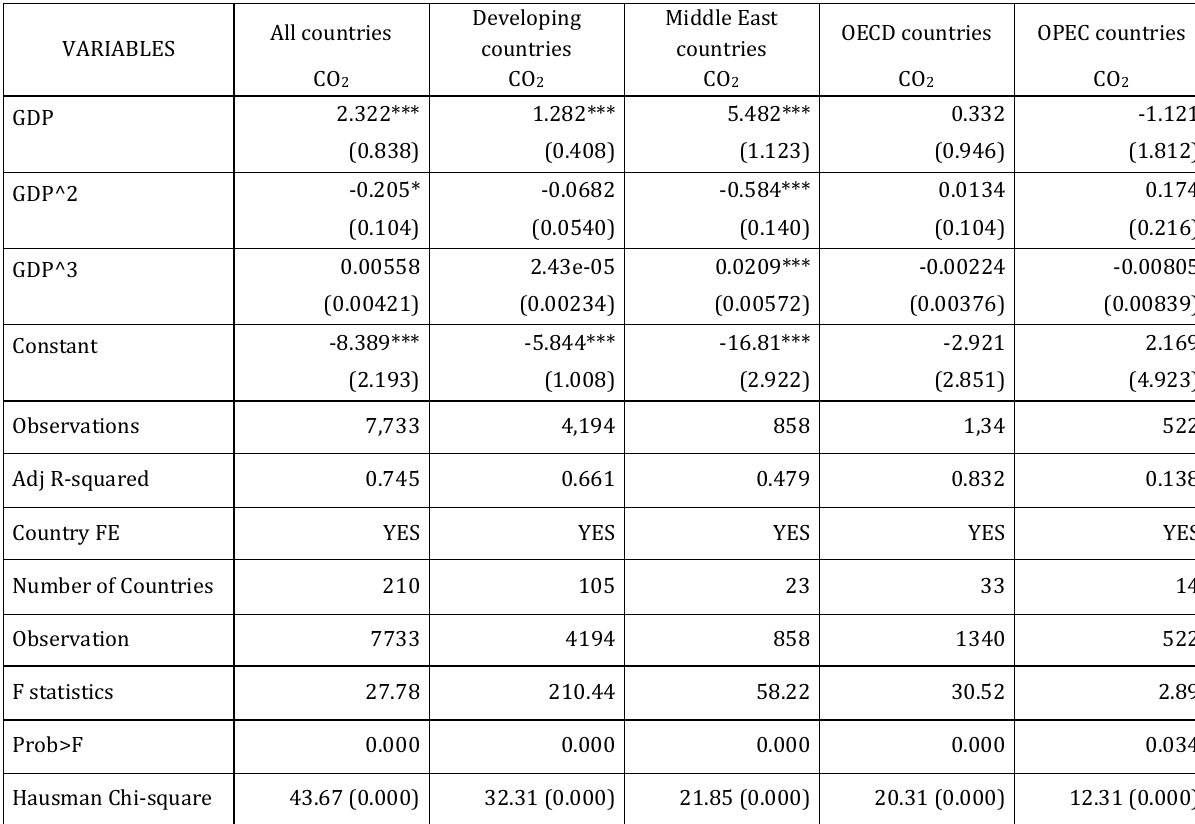
Table 3. Fixed effect regression